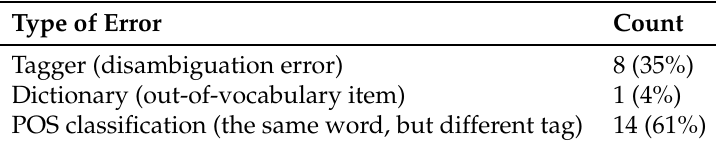
Table 16. Statistics of POS tagging errors in the experiment with Y10, the JK+KK dictionary, and the n-gram+TF based